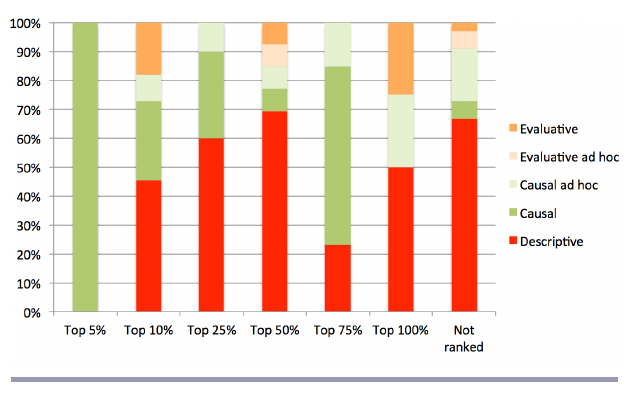
Fig. 7 . Research ambition across journal ranking positions.